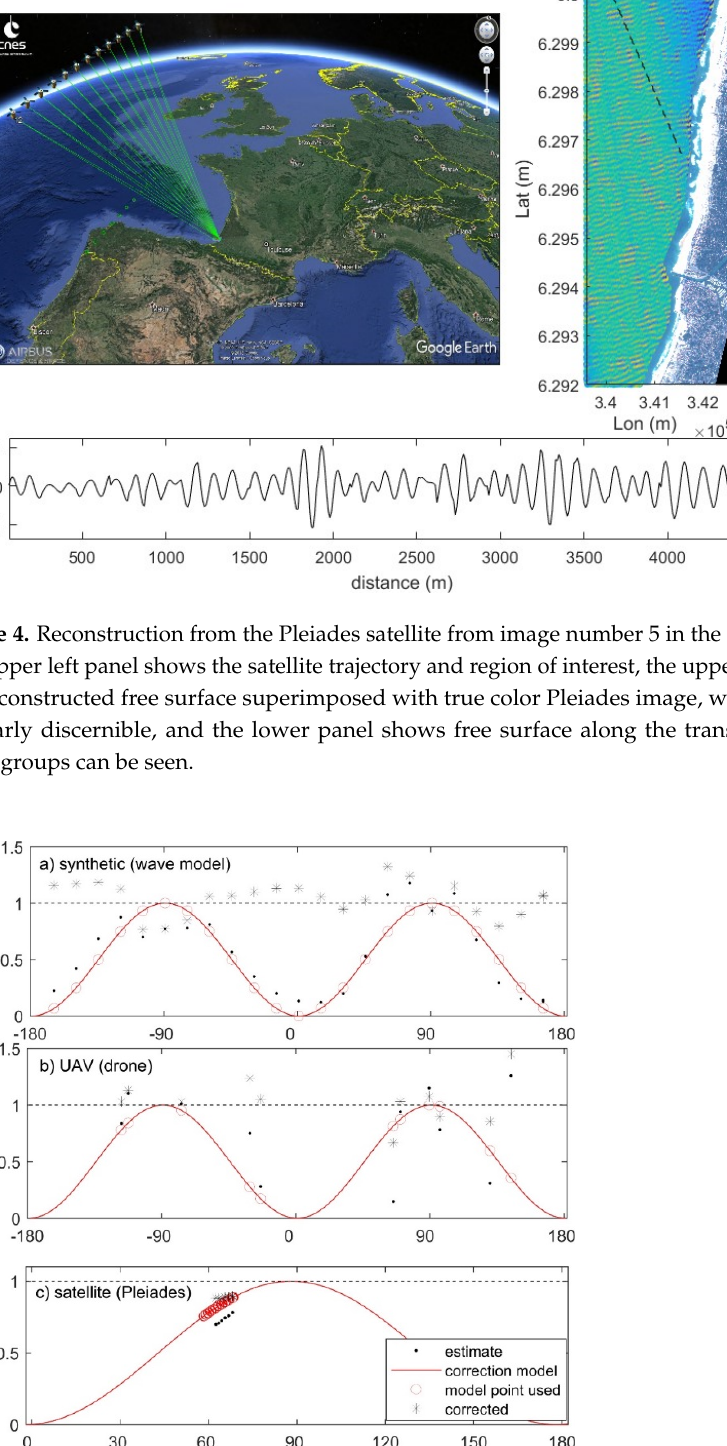
Figure 5. Sensitivity of the wave energy estimation to the relative view angle to wave crest for ( a ) the synthetic dataset (wave model), ( b ) UAV (drone) flights and ( c ) satellite (Pleiades) sequence. Significant wave height Hs est is computed from spatial variance of free surface, while Hs obs is computed from in-situ sensors for real data cases or from variance of free surface for the model case.